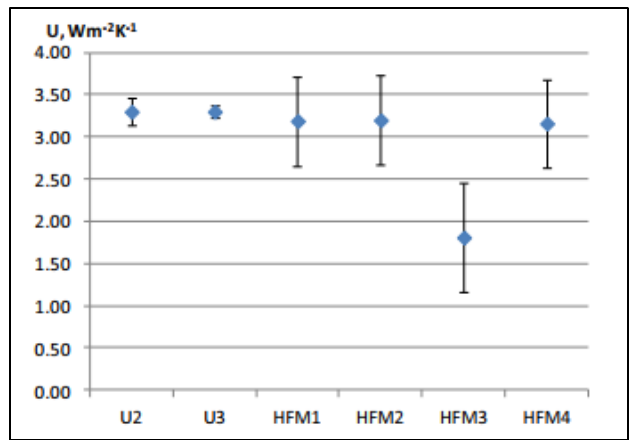
Figure 22. Comparison between in situ U-values [33].